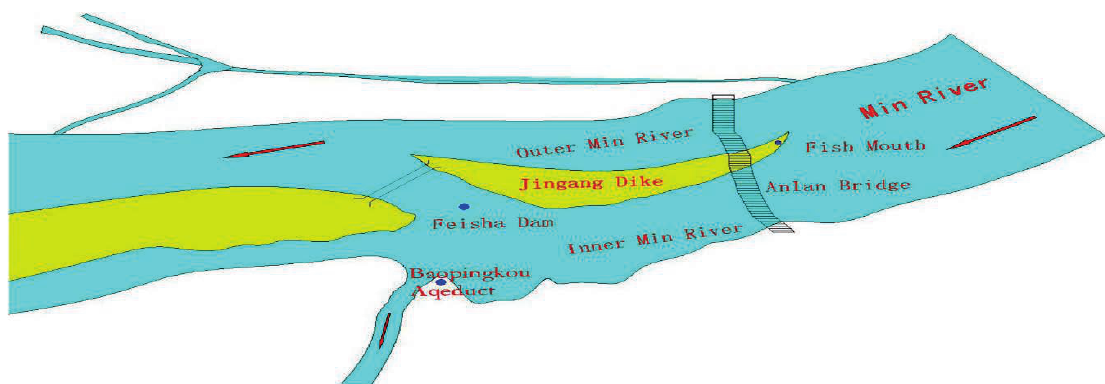
Fig. 1 Layout of Dujiangyan Water-conservancy Project.